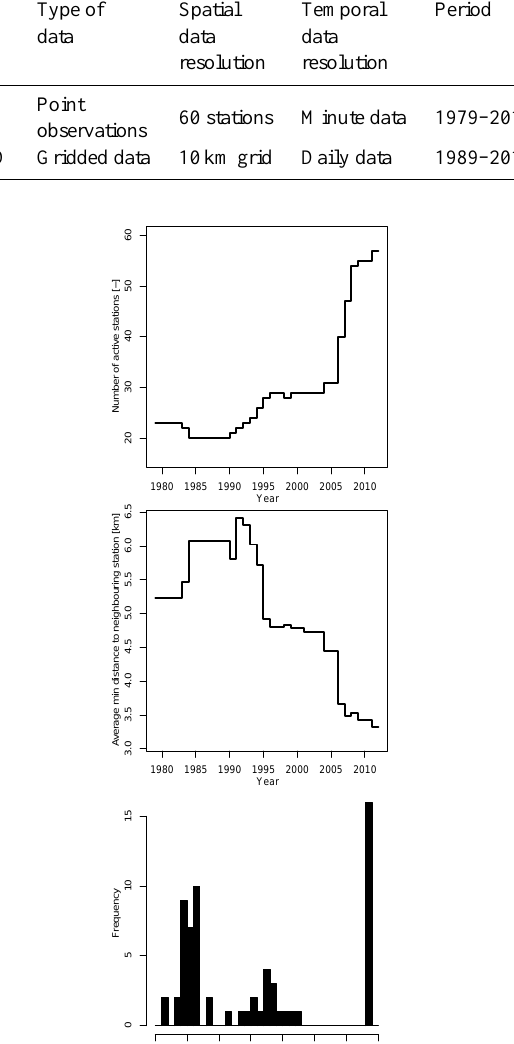
Figure 2. Temporal development in the number of stations in the SVK data set (top panel) and the average distance between closest neighbouring stations (middle panel), and the distribution of record lengths (bottom